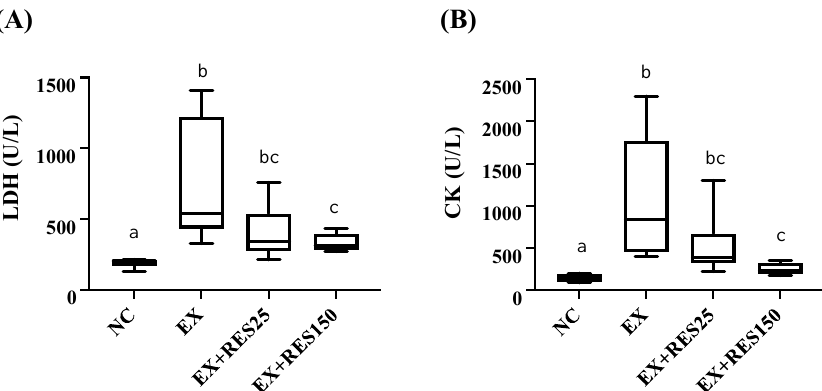
Figure 3. Effects of resveratrol on ( A ) lactate dehydrogenase and ( B ) creatine kinase with eccentric exercise–induced muscle damage. NC: control ( n = 6); EX: exercise ( n = 6); EX + RES25: exercise with resveratrol 25 mg/kg ( n = 6); EX + RES150: exercise with resveratrol 150 mg/kg ( n = 6). Data are presented as mean ± SEM. Data were analysed using one-way analysis of variance and a t-test followed by the Bonferroni multiple comparison test. Superscript letters (a, b and c) in columns denote a significant difference ( p < 0.05).